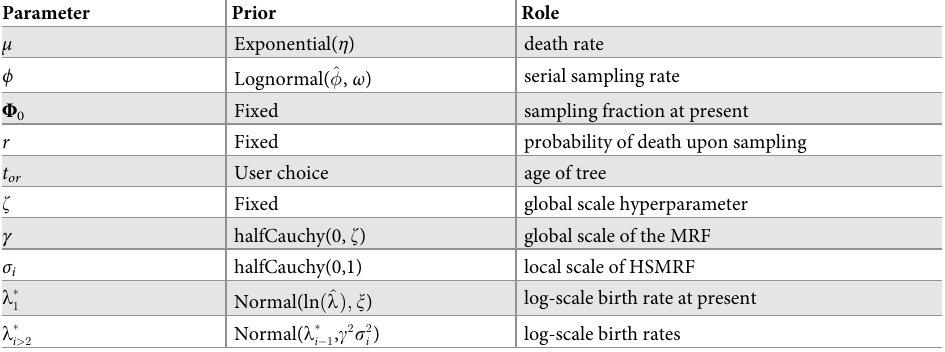
Table 1. Model parameters, their prior distributions, and their role in the model. In most of our analyses, we assume a constant death rate, μ , with an Exponential prior with rate parameter η = 10. In phylodynamic applications, there may be more information to set η , while in macroevolutionary examples one could instead employ an empirical Bayes approach. When there is serial sampling, we adopt an empirical Bayes approach to setting the prior on the sam- pling rate, ϕ , using a guess at the tree age and the number of tips to obtain ^ � . In practice we set ω = 1.17481. In analyses without serial sampling, ϕ = 0. For details on computing ^ � , see S1 Text. The sampling fraction at present, Φ 0 and the probability of death upon sampling, r are taken to be known a priori . The age of the tree, t height if the tree is data, else it is a variable with the prior determined by the user. For models with n = 100 intervals, we set z = 0.0021 for HSMRF-based models and z = 0.0094 for GMRF-based models, while for models with other n , we provide code for setting z . The GMRF-based model lacks local scale parameters σ . We adopt an empirical Bayes approach to setting the prior on the first log-birth-rate using a guess at the tree age and the number of tips to obtain ^ l � In practice we set ξ = 1.17481. In models where the death rate varies, the previously discussed prior on μ serves as the prior on μ 1 , and the rest of the prior is accomplished via an MRF model exactly as with the birth